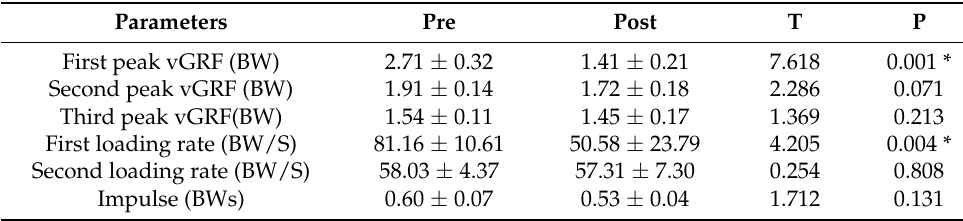
Table 1. The results of the